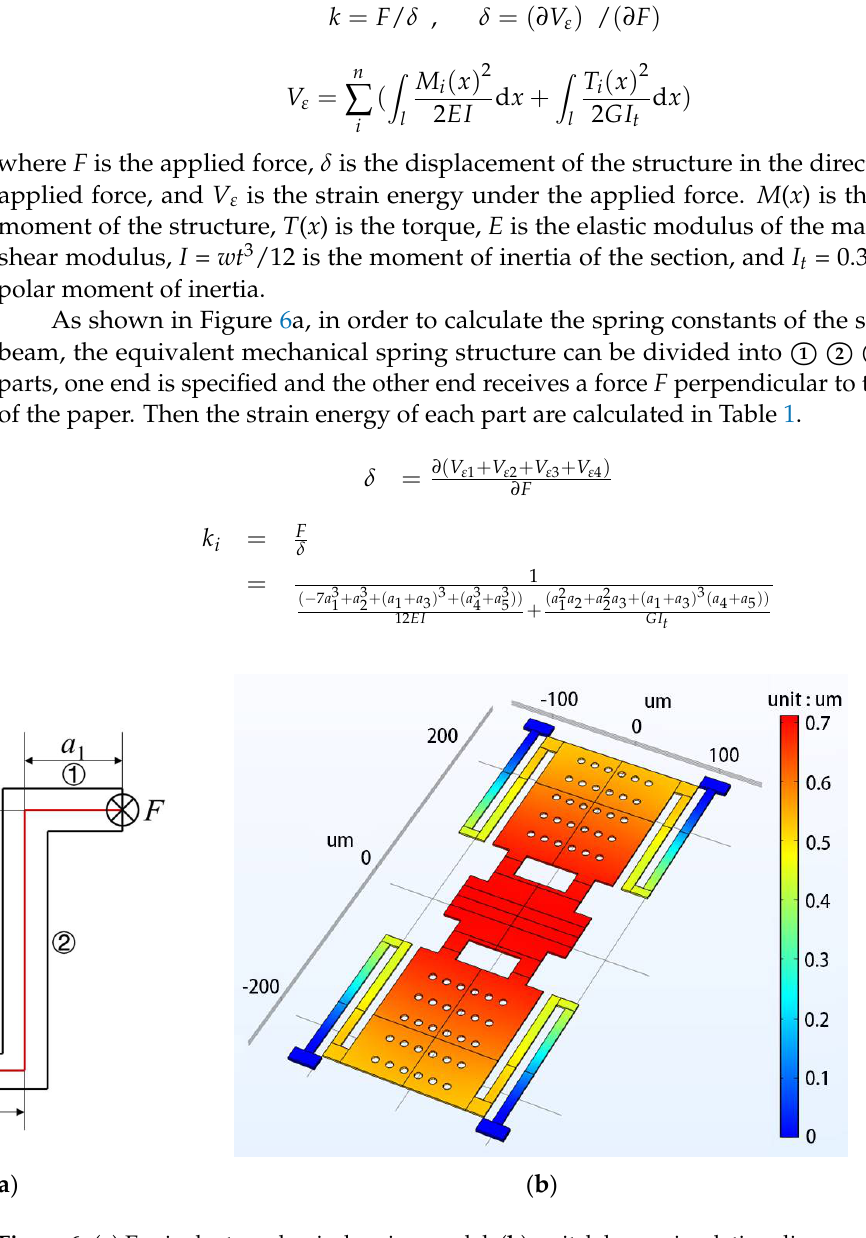
Figure 6. ( a ) Equivalent mechanical spring model; ( b ) switch beam simulation diagram.